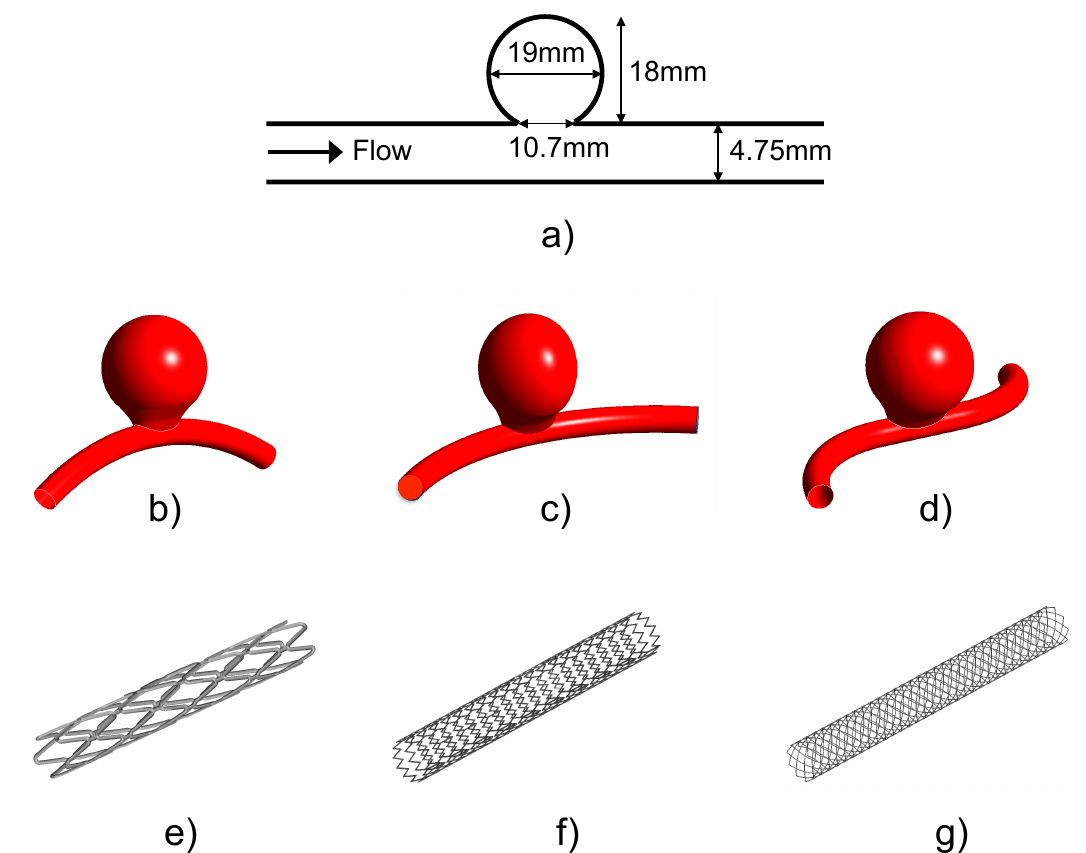
Figure 1. ( a ) Geometrical characteristics of the giant saccular aneurysm employed in this study [13] with the baseline straight artery [28] and the considered geometric configurations. Sidewall aneurysm model with ( b ) V-bent artery, ( c ) C-bent artery and ( d ) S-bent artery. Straight configuration of the FDSs: ( e ) STENT 1 (90% porosity), ( f ) STENT 2 (80% porosity) and ( g ) STENT 3 (70%